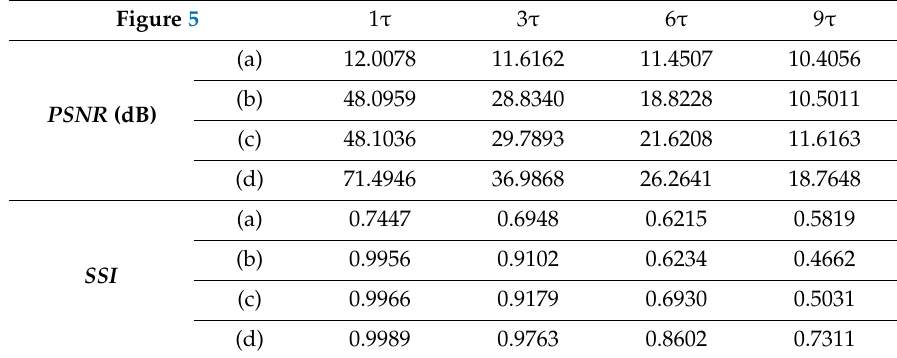
Table 3. Quantitative comparison of recovered images for Figure 5.